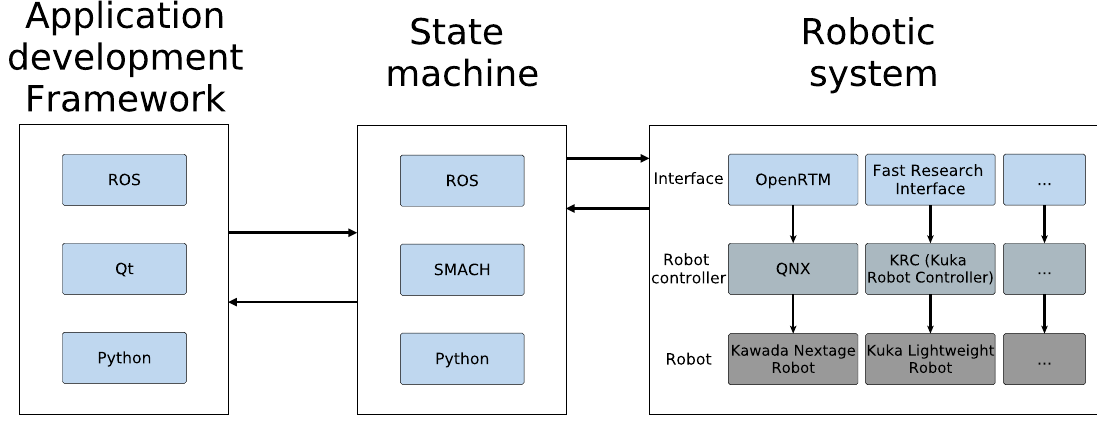
Figure 1. Proposed overall architecture. The figure shows how it is divided into three